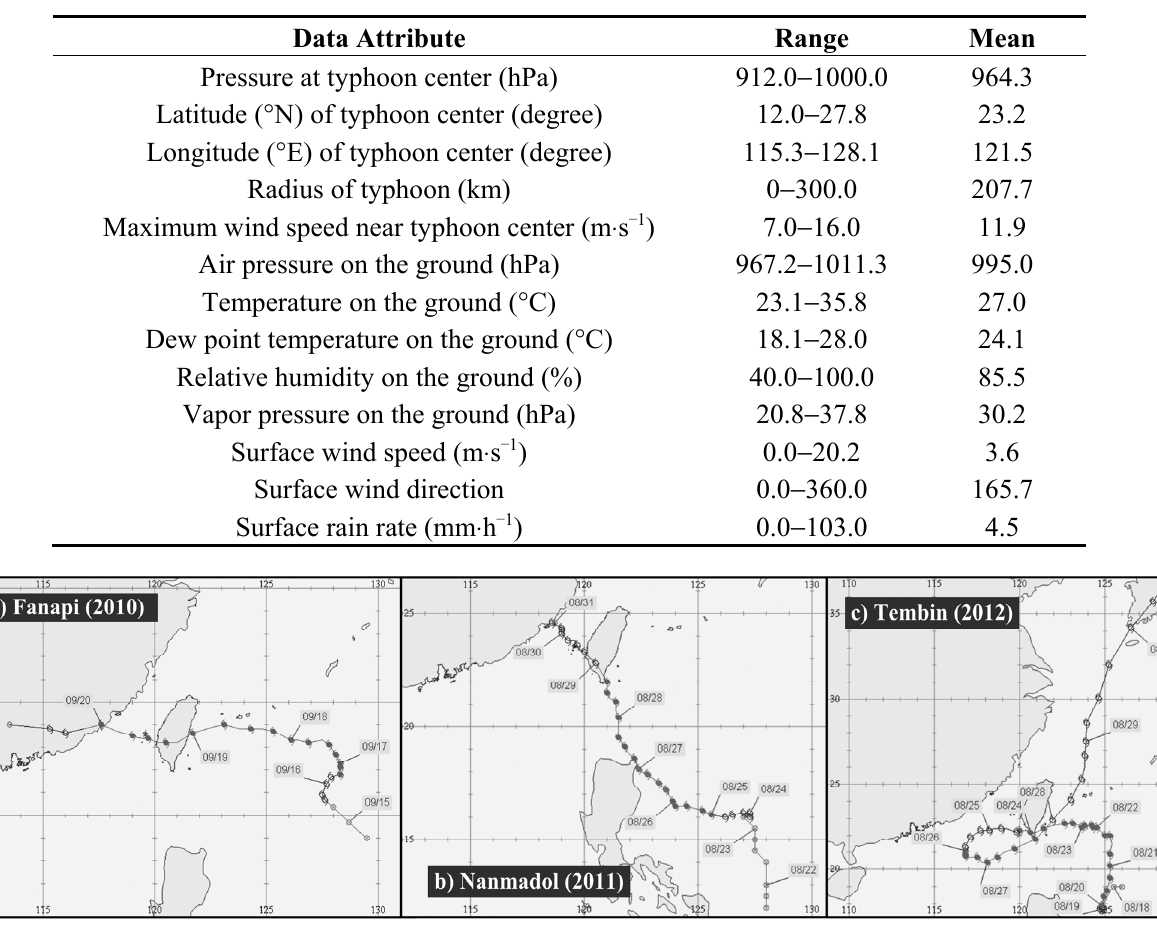
Figure 4. Typhoon tracks of ( a ) Fanapi (2010); ( b ) Nanmadol (2011); and ( c ) Tembin